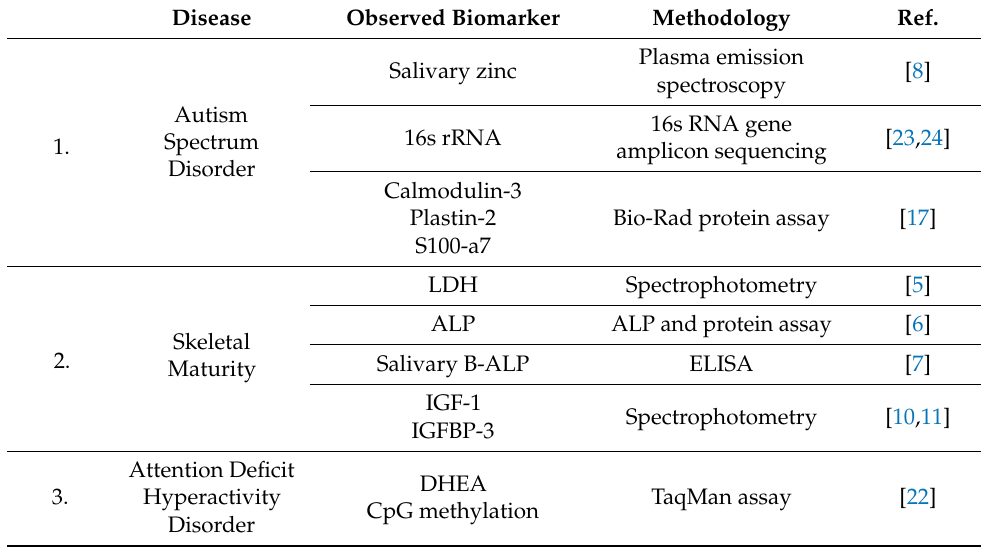
Table 2. Most commonly recurring developmental conditions and their respective